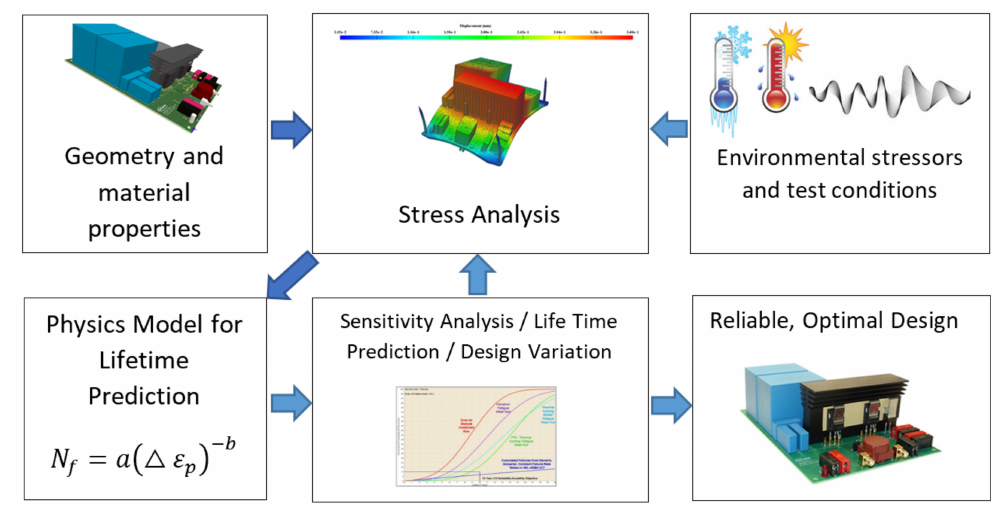
Figure 2. Application of physics of failure (PoF) for power